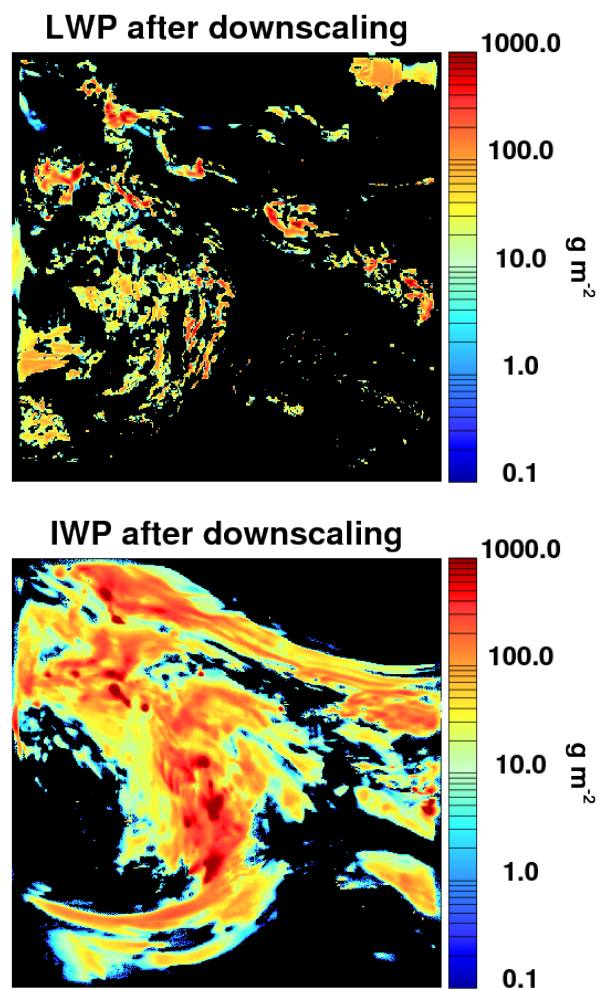
Fig. 2. Cloud liquid (top) and cloud ice water path (bottom) for the COSMO-EU grid after resolution